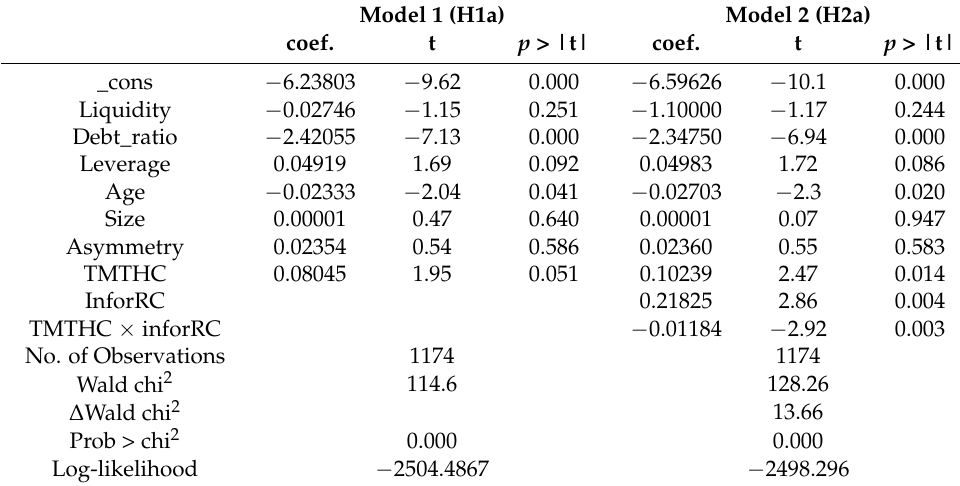
Table 4. General linear regression for executive human capital and ROA.